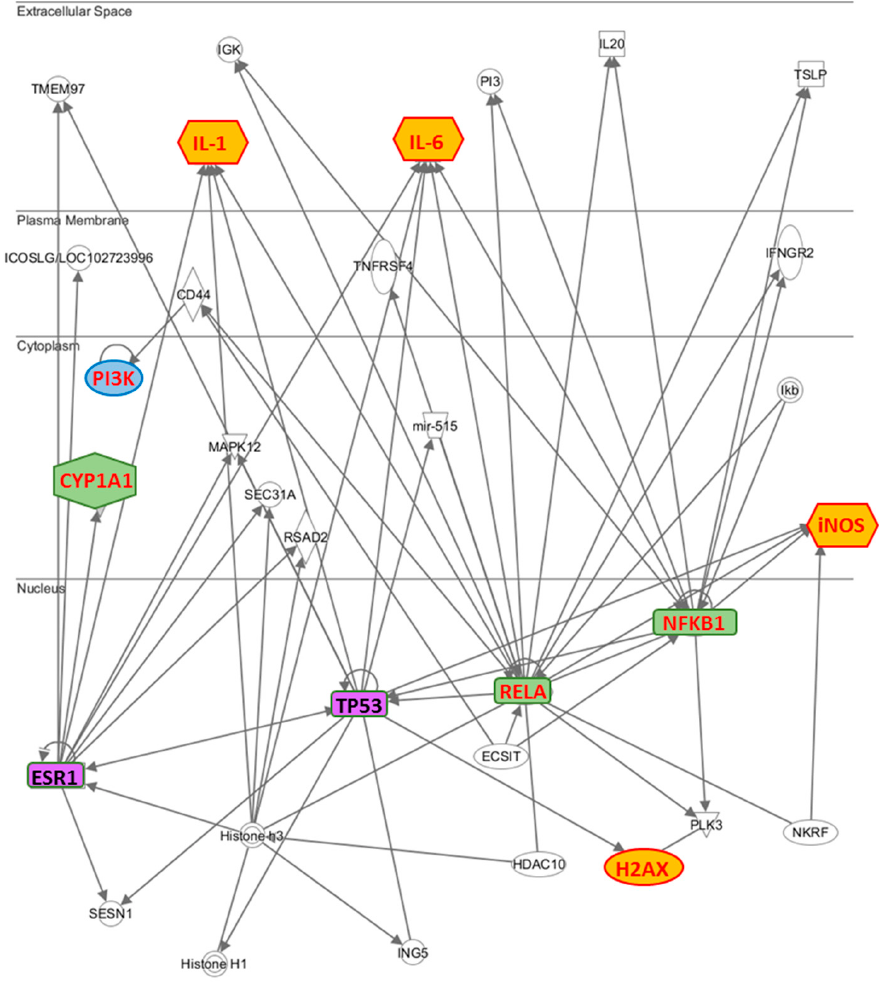
Figure 5. Interactomic analysis by Ingenuity Pathway Analysis (IPA) of significant molecules. The interactome shows the close functional association between the molecules evaluated in this work as well as the paths in which other functionally relevant molecules are also involved. In details, we report in yellow the genes modulated only in MCF7 cells like three up-regulated genes (IL-1, IL-6 and iNOS) and the activated H2AX, in cyan PI3K that is activated only in MDA-MB231 cells, in green the genes (CYP1A1, NFKB1 and RELA) that are up-regulated in both cell lines, and in pink the other two HUB genes, TP53 and ESR1.